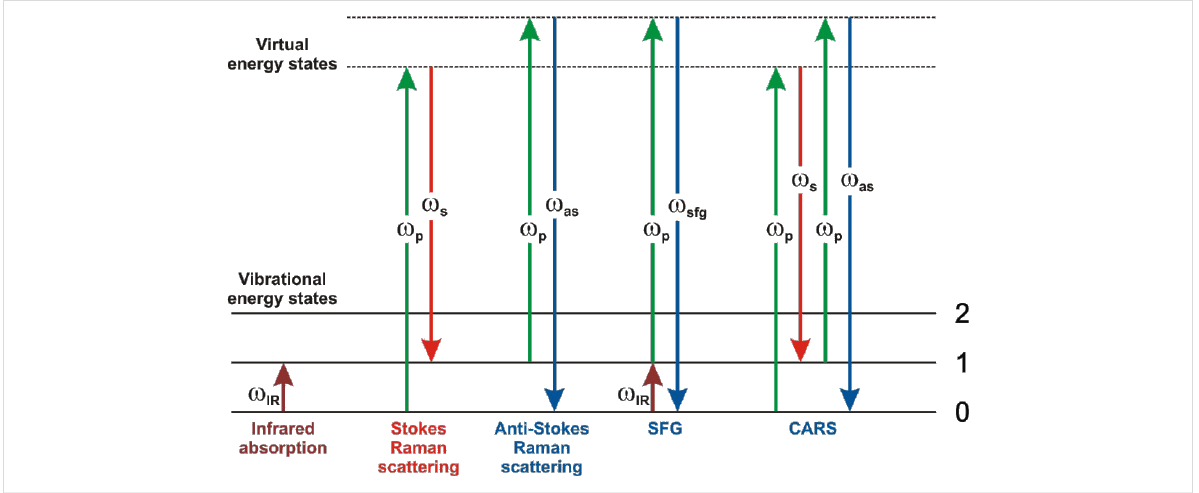
Figure 1: Photon diagrams for different linear and nonlinear optical processes. Solid horizontal lines are real vibrational energy states of matter, while dashed lines are virtual states. Upward pointing arrows correspond to incoming photons that lead to an excitation of matter, while downward pointing arrows correspond to emitted photons that relax the energy excitation of matter. The optical processes depicted here are linear infrared, spontaneous Stokes and anti-Stokes Raman, nonlinear sum-frequency generation, and coherent anti-Stokes Raman transitions, from left to